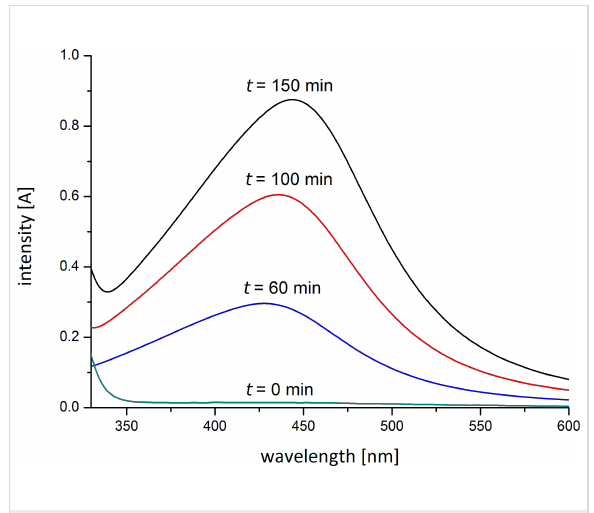
Figure 2: UV–vis absorption spectra of silver nanoparticles 2a after different stirring